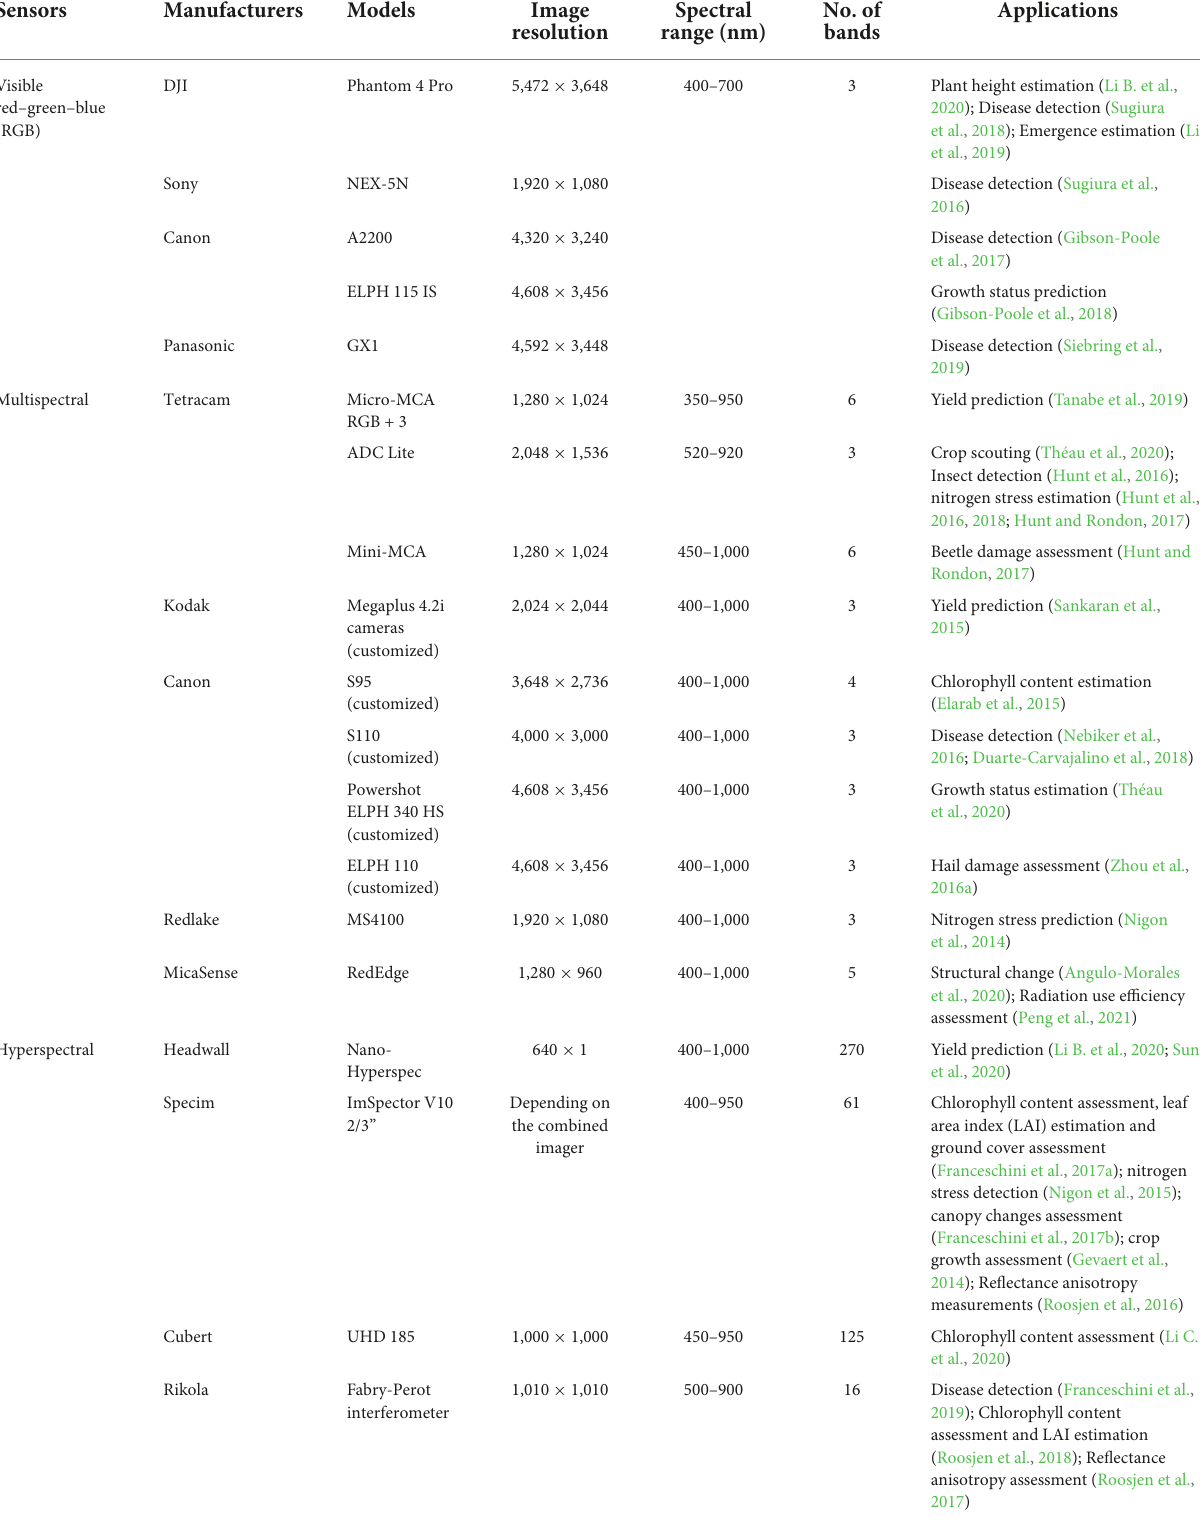
TABLE 1 Sensors and their applications in potato trait